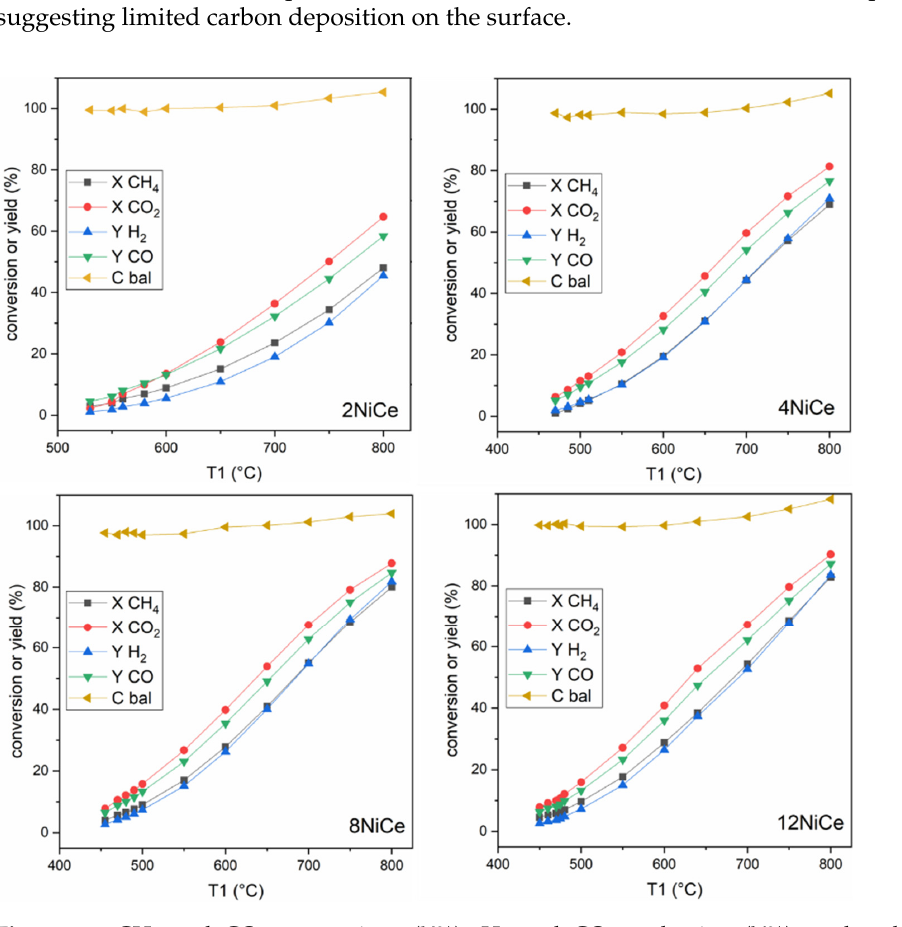
Figure 6. CH 4 and CO 2 conversions (X%), H 2 and CO production (Y%), and carbon balance (C bal